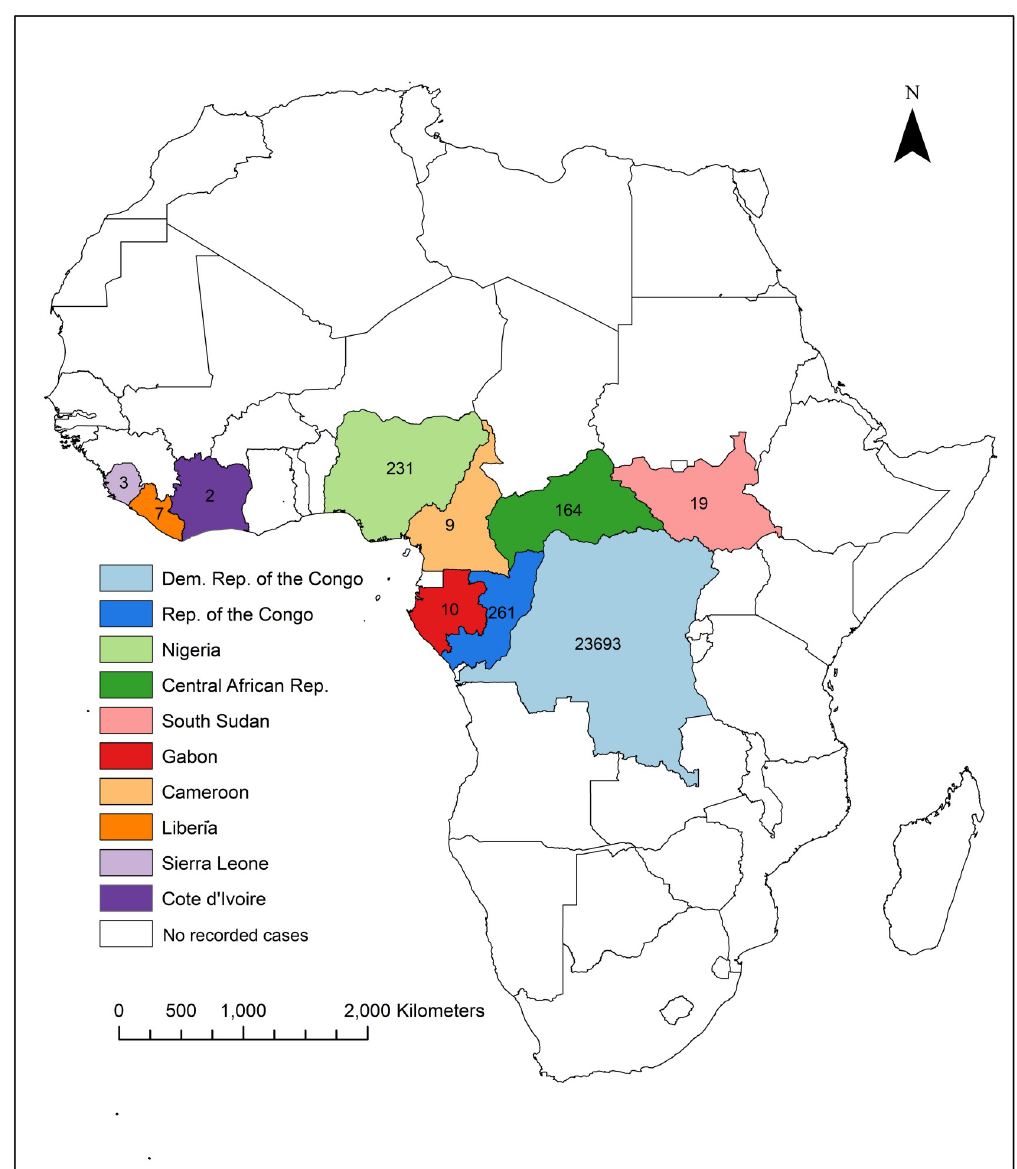
Fig 2. Map of countries and total number of suspected cases identified by this review, 1970-2018 � . Created using ArcGIS. � Suspect cases in DRC are reported to exceed 1000 per year[1] and therefore the total reported cases is likely to exceed what was accessible for